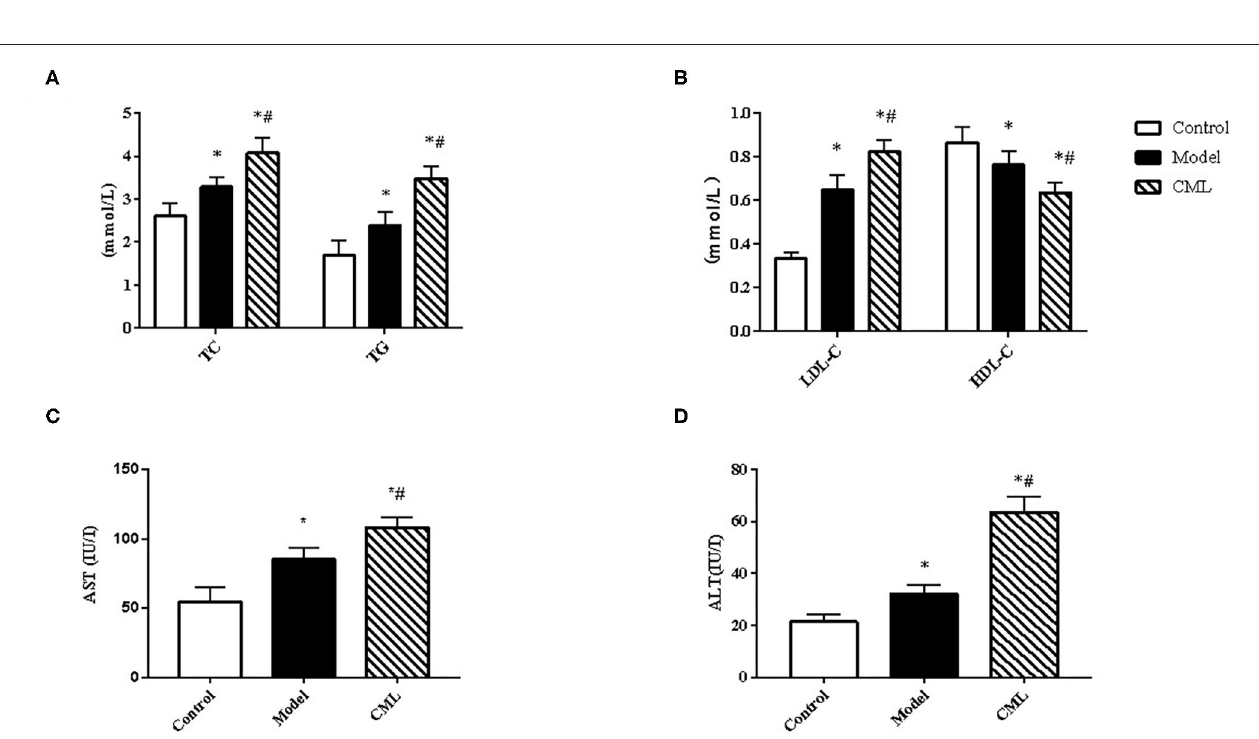
FIGURE 4 | Observe the effect of 16 weeks CML on related biochemical indexes of ApoE − / − mice (A) . Total cholesterol (TC), Triglyceride (TG) (B) . Low-density lipoprotein (LDL-C) and high-density lipoprotein (HDL-C) (C) . Aspartate aminotransferase (AST) (D) . Alanine aminotransferase (ALT) levels were measured using an automatic biochemical analyzer. All data are expressed as the means ± SEM. * P < 0.05, compared with control group; # P < 0.05, compared with model group.